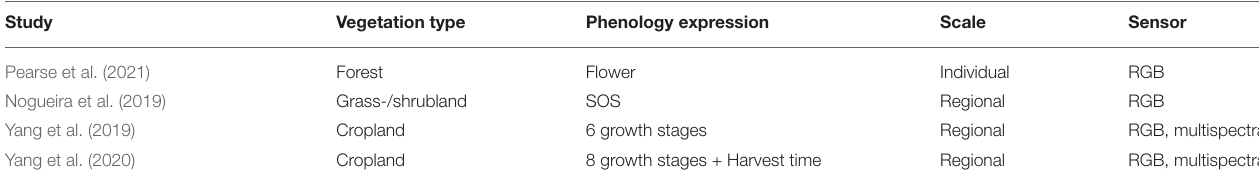
TABLE 3 | Overview of studies that used UAVs imagery for phenological study with DL methodology.